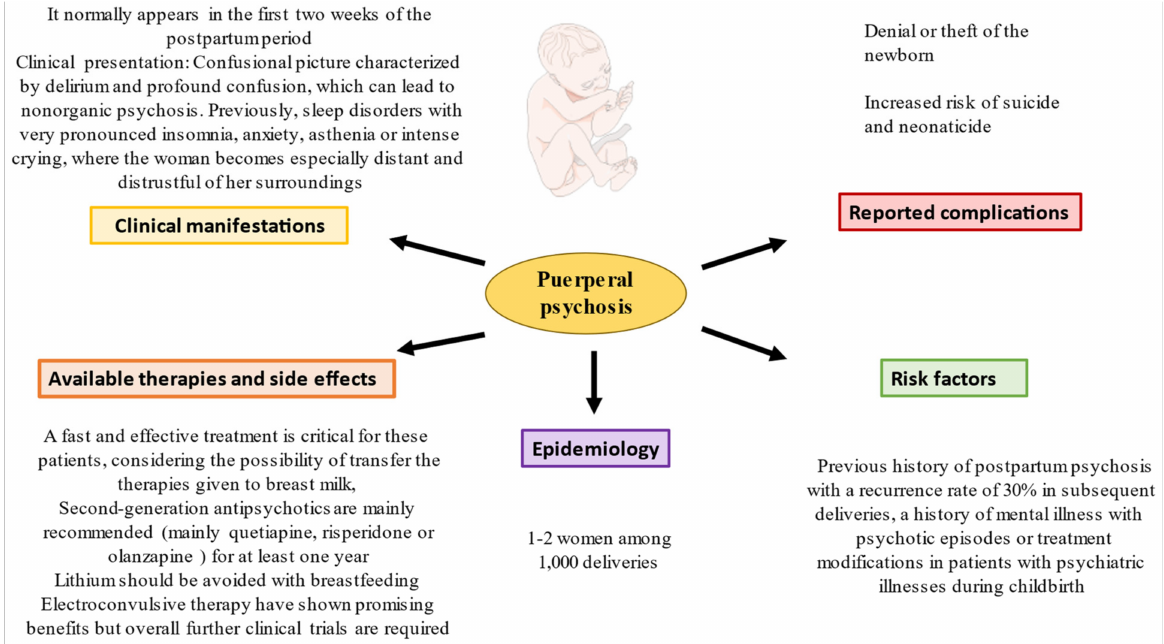
Figure 2. A summary of the main data of puerperal